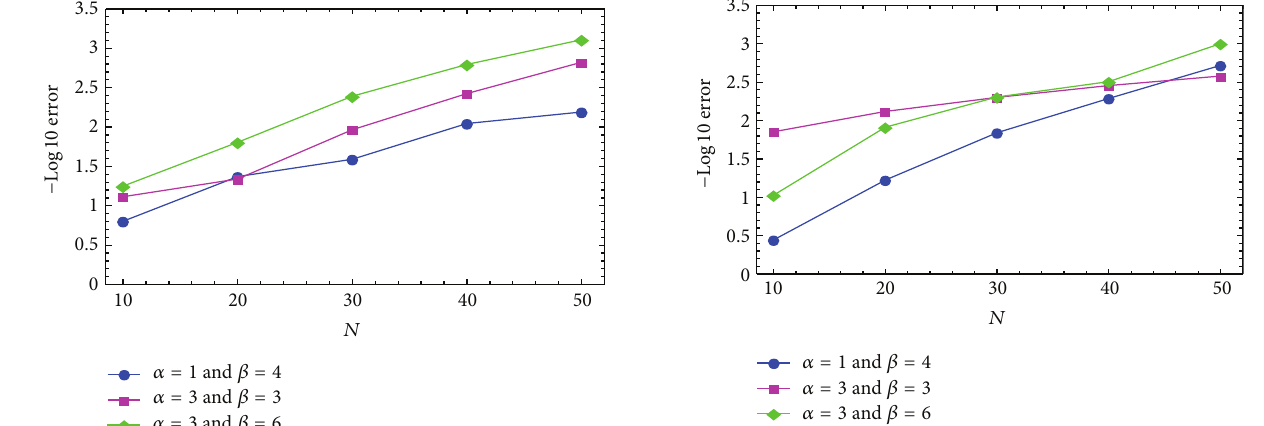
Figure5: Maximumabsoluteerror(case I)byusingMGLT(Radau) with the various choices of 𝑁 .